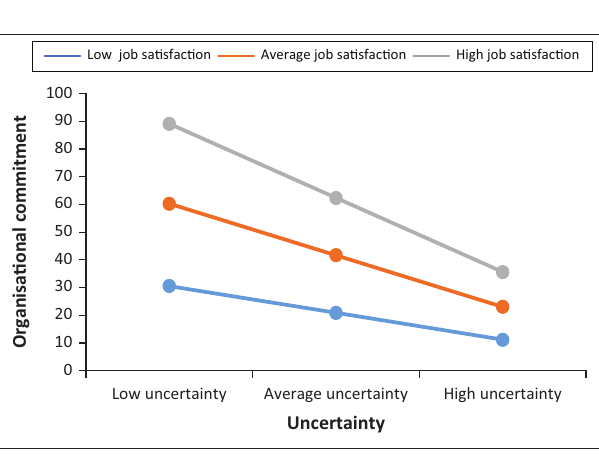
FIGURE 4: Testing the interaction effect of job satisfaction on the relationship between uncertainty and organisational commitment.